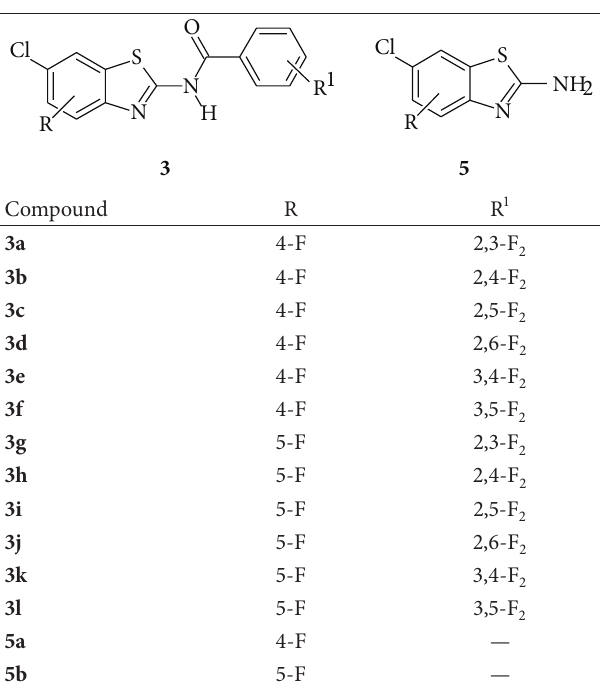
Table 1: Structures of compounds 3a-l and 5a, b